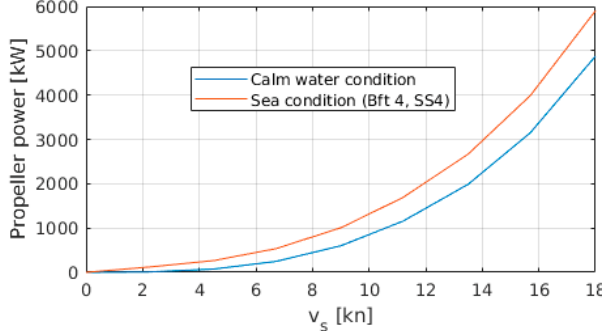
Figure 2. Results of the power prediction using ShipCLEAN. The ferry operates on a 23 nm long route between Rostock (Germany) and Gedser (Denmark) with a course over ground of 165 deg (towards Rostock) and 345 deg (towards Gedser). The operational speed of the vessel is about 16